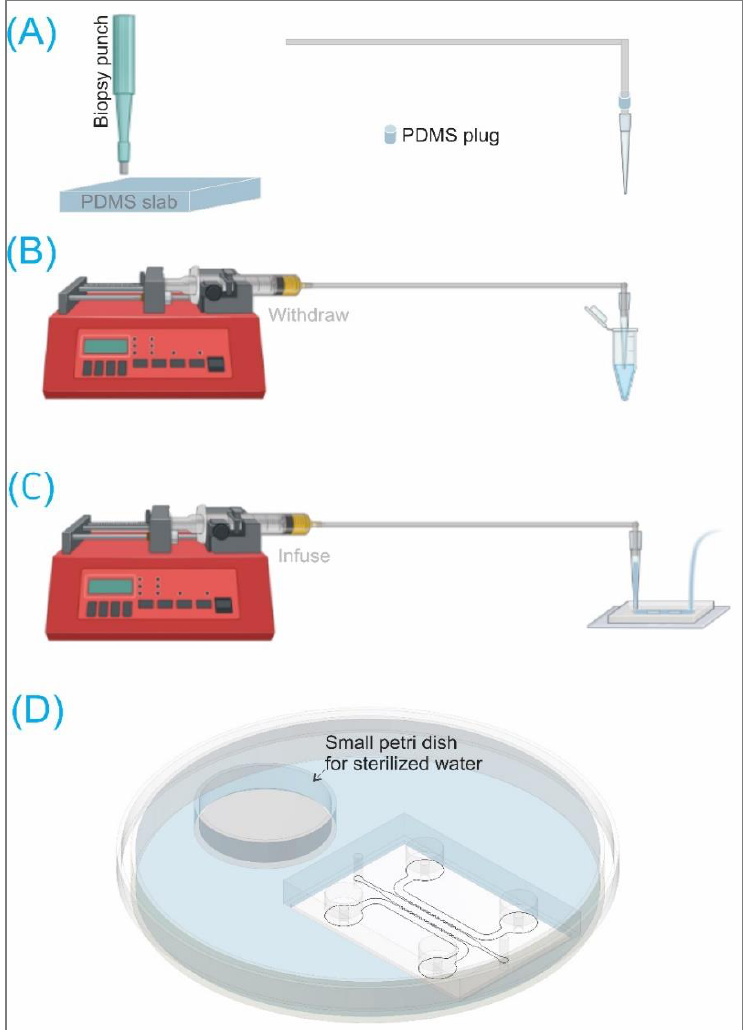
Figure 2. Schematics of: ( A ) Fabricating a PDMS plug used to connect a Cole-Parmer PTFE microbore tubing 0.012 ″ ID and a pipette tip. ( B ) Withdrawing cell suspension using a (New Era Pump) syringe pump and tubings. ( C ) Infusing cell suspension. ( D ) A tissue chip in a large petri dish containing a smaller petri dish having sterilized water acting as a humidifier for cell seeding in an incubator at 37 °C with 5% CO 2 . Figure partially made using Biorender.com.